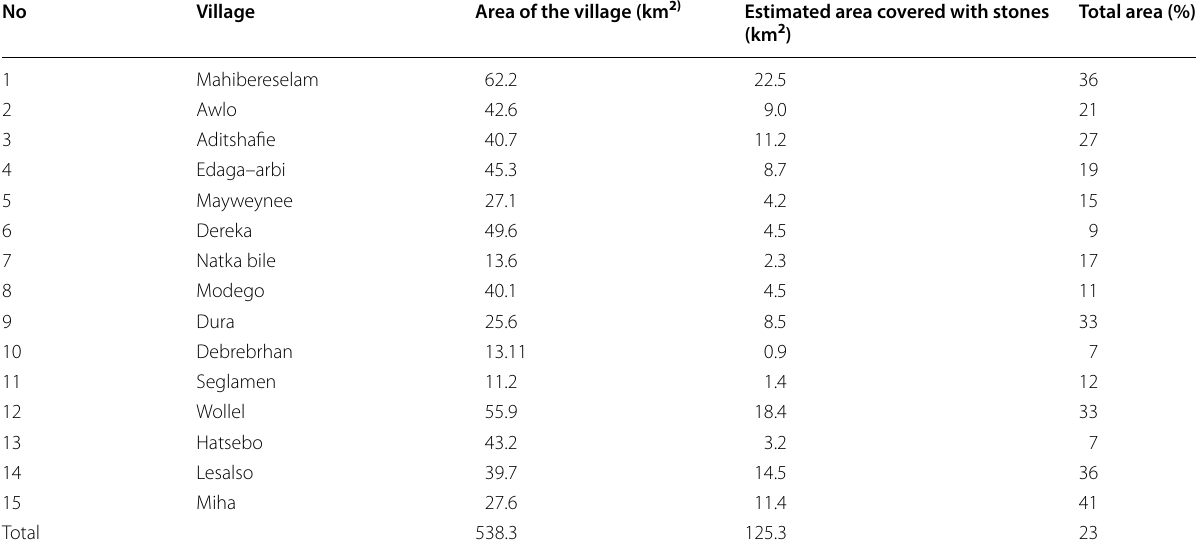
Table 1 Eestimated areas covered with stones in Laelay Maychew district. Source: (WOWRED,